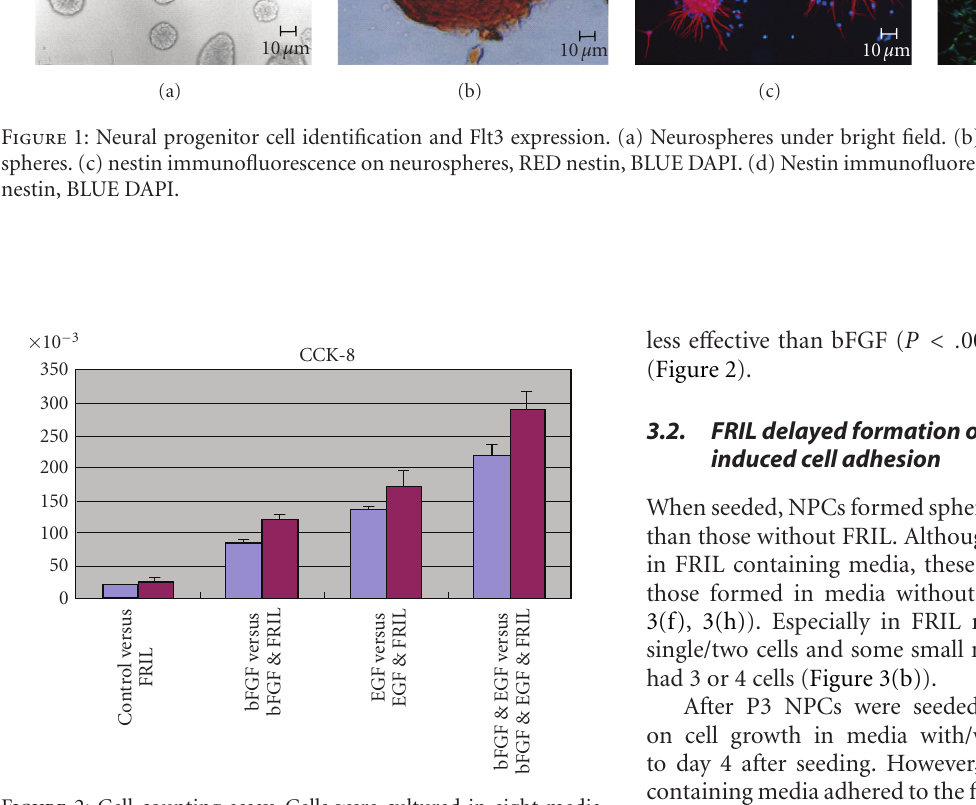
Figure 2: Cell counting assay. Cells were cultured in eight media with di ff erent growth factors combination represented in figure by control, FRIL, bFGF, bFGF&FRIL, EGF, EGF&FRIL, bFGF&EGF, bFGF&EGF&FRIL. Cell numbers were transferred into absorption value obtained from microplate reader Bio-Rad Model